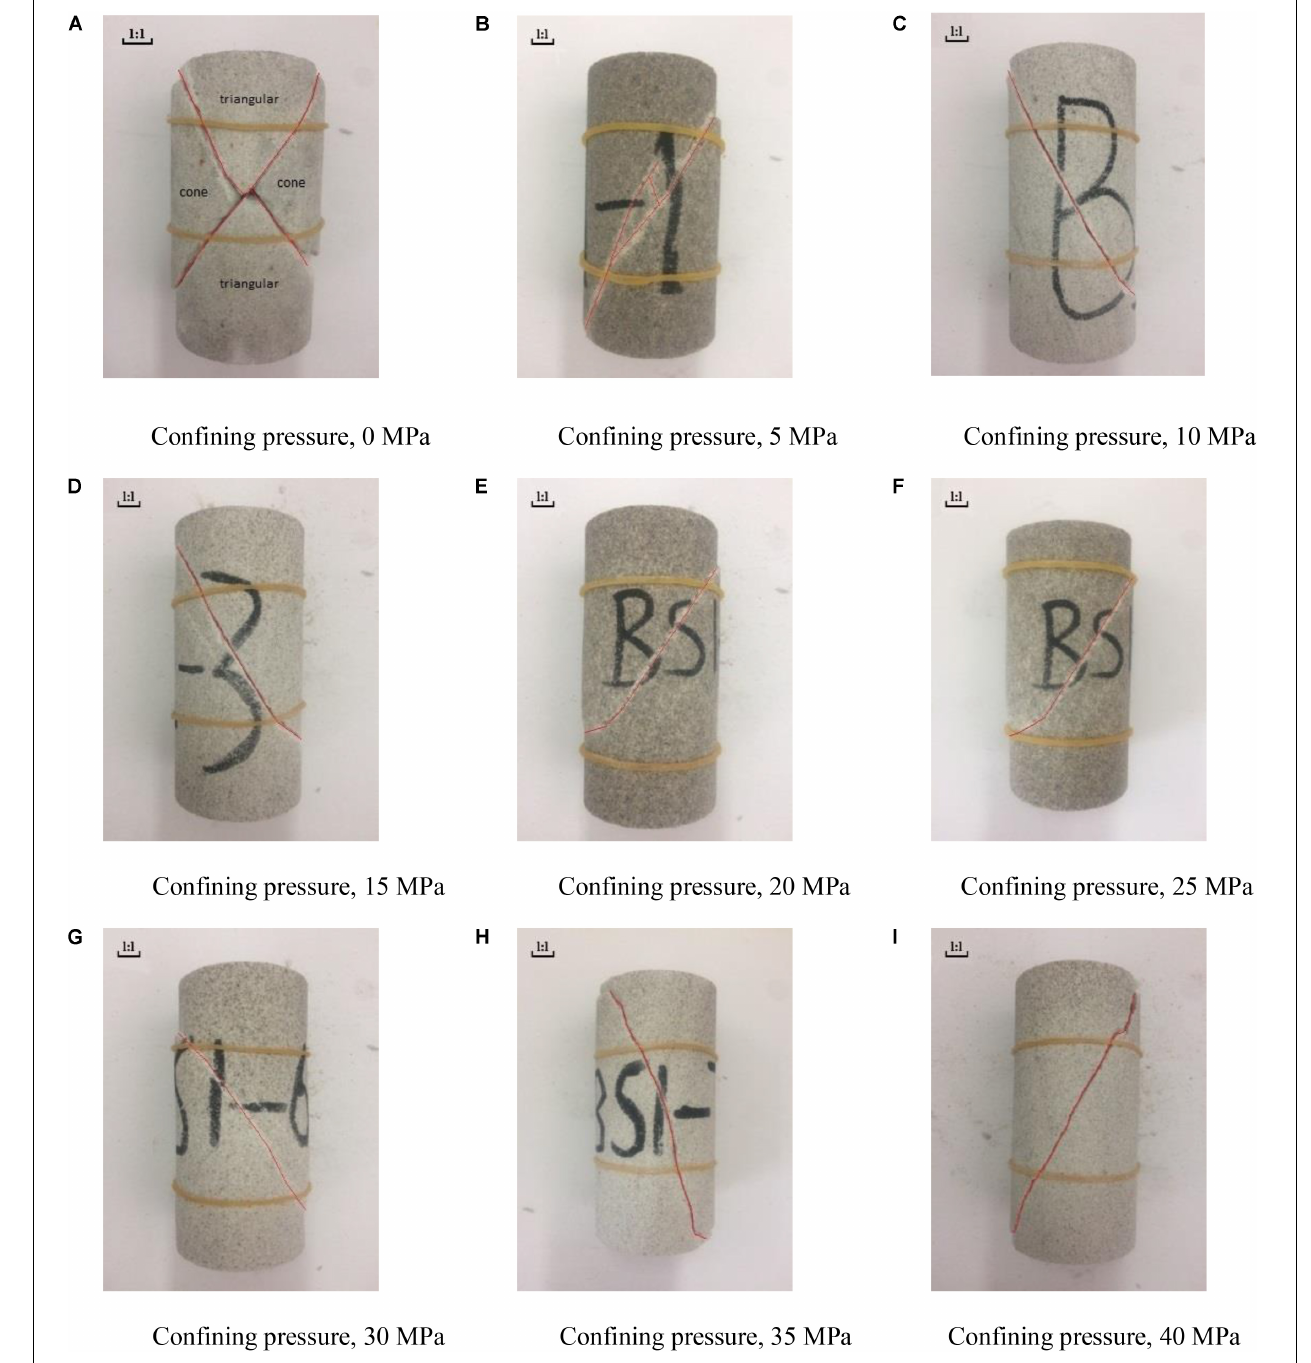
FIGURE 2 | Sandstone failure morphologies under uniaxial and triaxial loading. (A) Confining pressure, 0 MPa; (B) Confining pressure, 5 MPa; (C) Confining pressure, 10 MPa; (D) Confining pressure, 15 MPa; (E) Confining pressure, 20 MPa; (F) Confining pressure, 25 MPa; (G) Confining pressure, 30 MPa; (H) Confining pressure, 35 MPa; (I) Confining pressure, 40